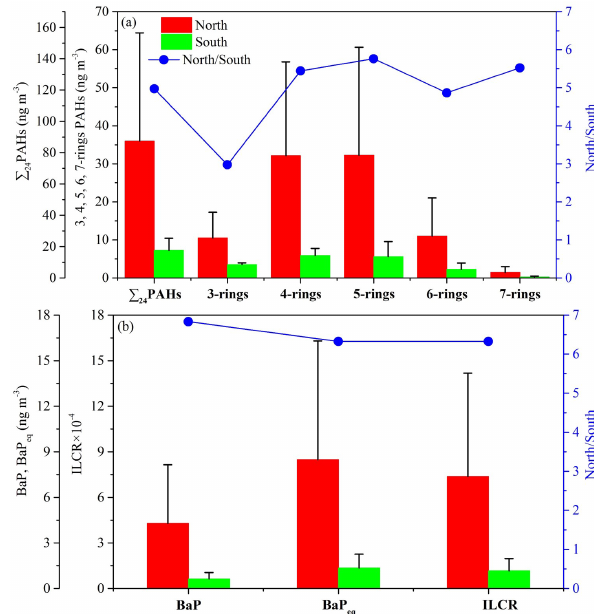
Figure 3. Comparison of (cid:80) 24 PAHs between northern and southern China. Three–seven-ring PAHs (a) and BaP, BaP eq and ILCR (b) .